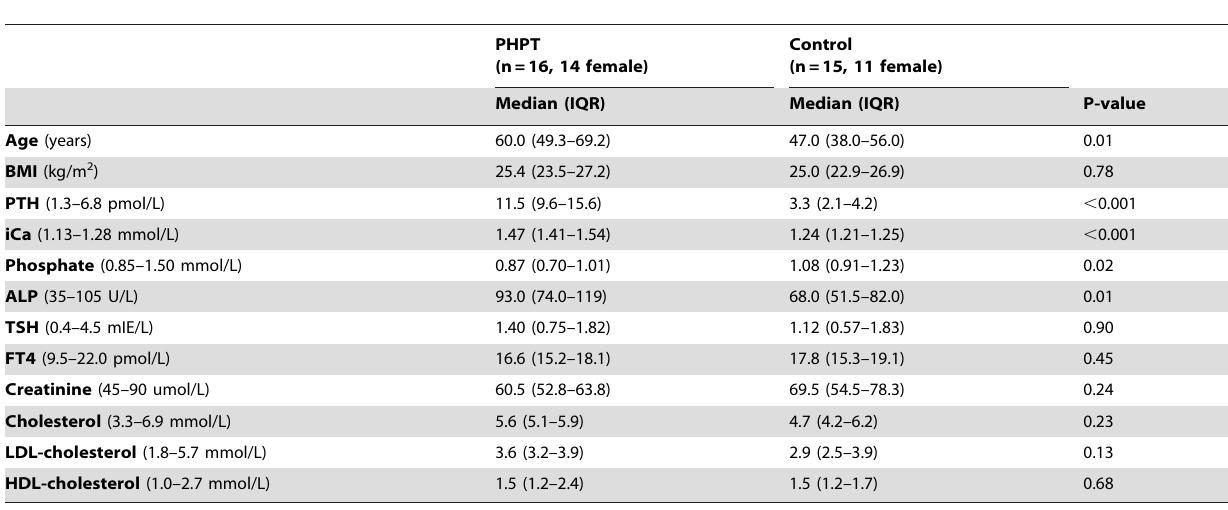
Table 2. Anthropometric and biochemical measurements of the PHPT patient and control groups.